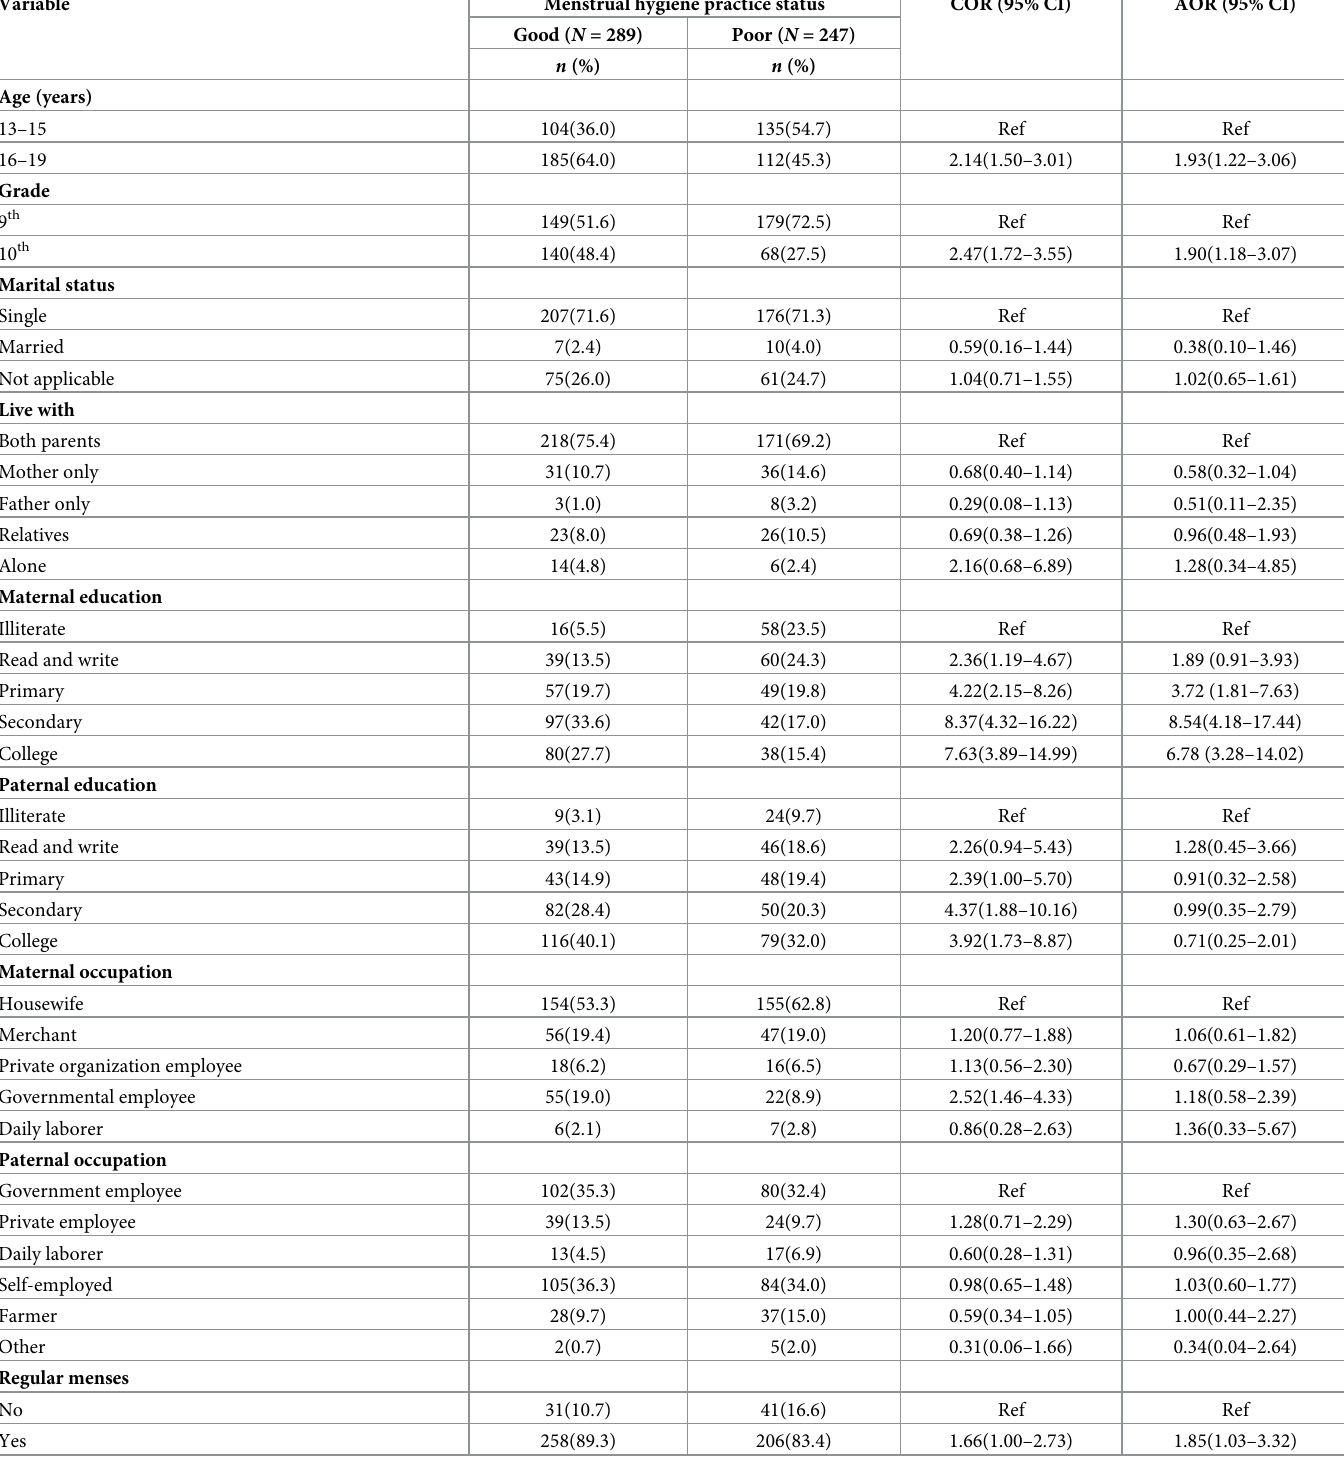
Table 9. Bivariate and multivariable logistic regression analysis for factors associated with menstrual hygienic practices among high school girls in Dessie City, northeastern Ethiopia, 27 January to 6 March